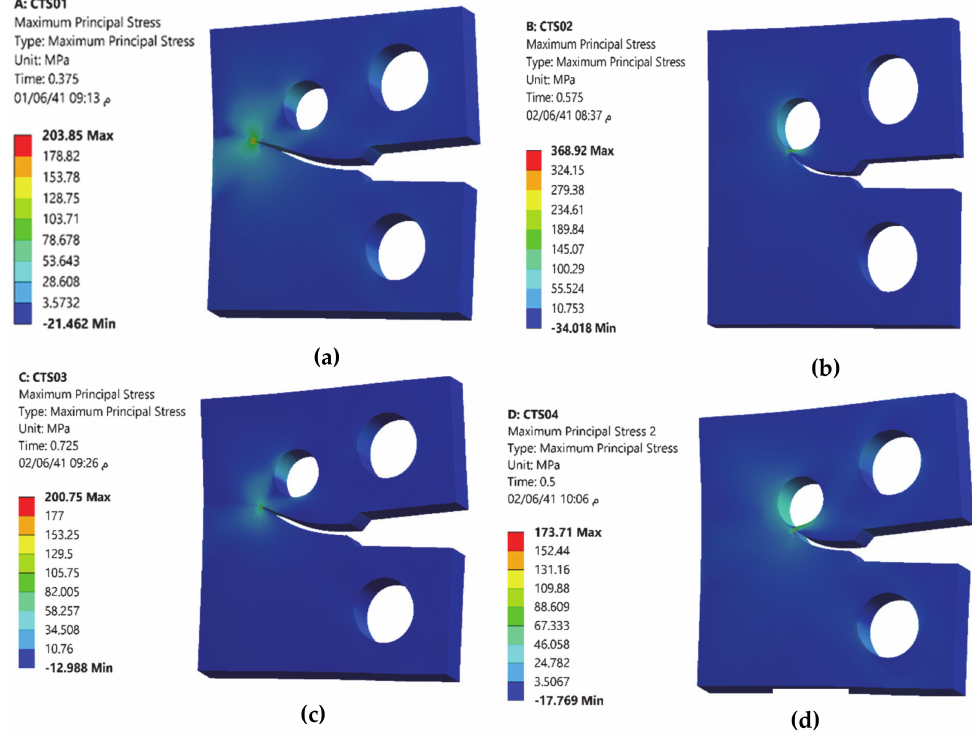
Figure 8. Maximum principal stress distribution for di ff erent configuration of CTS, ( a ) CT01, ( b ) CT02, ( c ) CT03 and ( d )